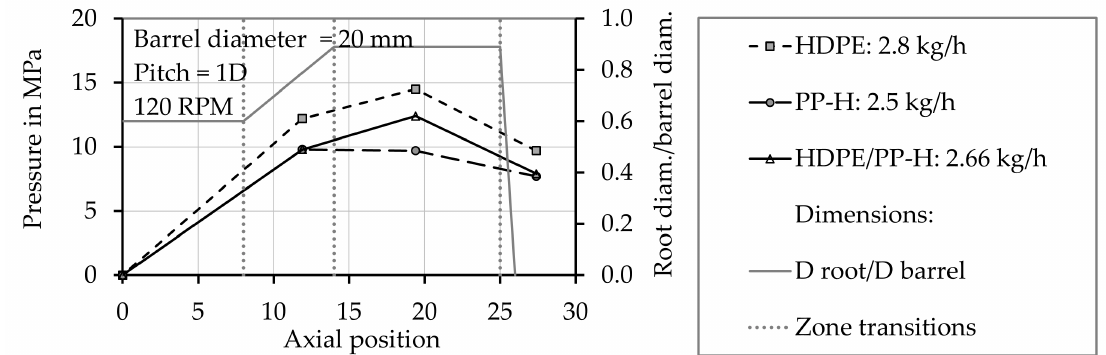
Figure 12. Comparison of the measured pressure profiles when processing pure PP-H, grade A, pure HDPE, and a mixture of 50 wt.% PP-H, grade A and 50 wt.% HDPE.